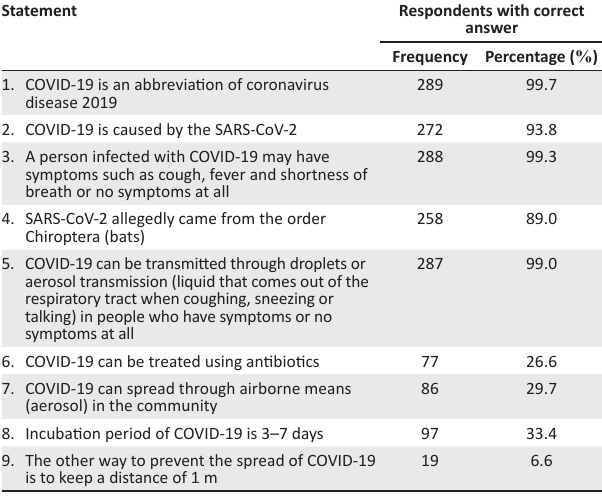
TABLE 4: Respondents’ answers related to knowledge of COVID-19 ( n =